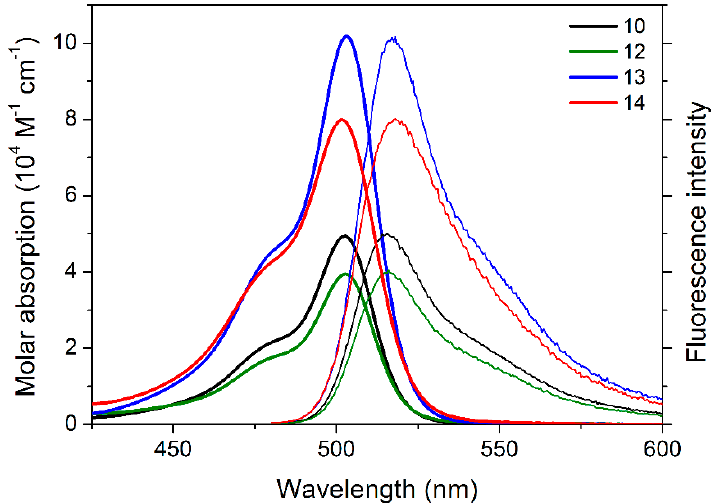
Absorption (bold line) and normalized fluorescence (thin line) spectra of boron- dipyrromethene (BODIPY)-labeled tetravalent ( 10 and 12) and hexavalent ( 13 ) derivatives in diluted solutions (2 µ M) of EtOAc. The corresponding spectra of compound 14 in water is also included.